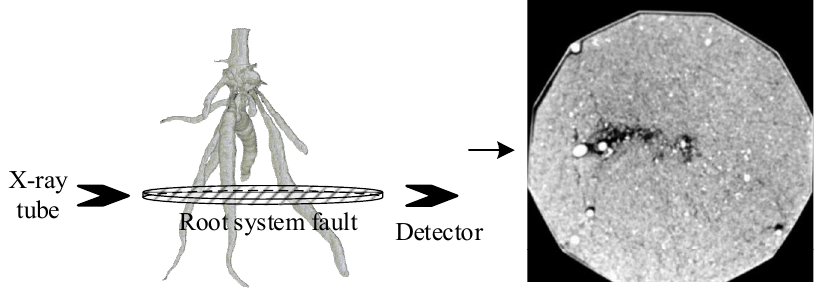
Figure 6. CT images of the fault of soil roots.